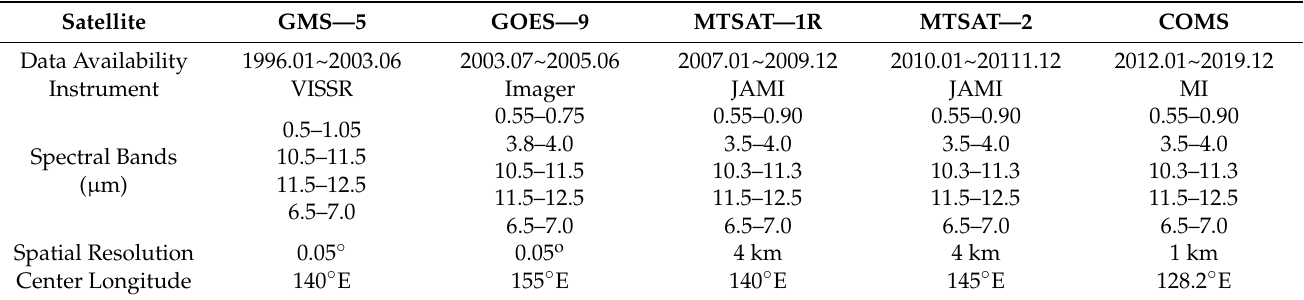
Table 2. Summary of geostationary satellite employed in the UASIBS–KIER model from 1996 to 2019.